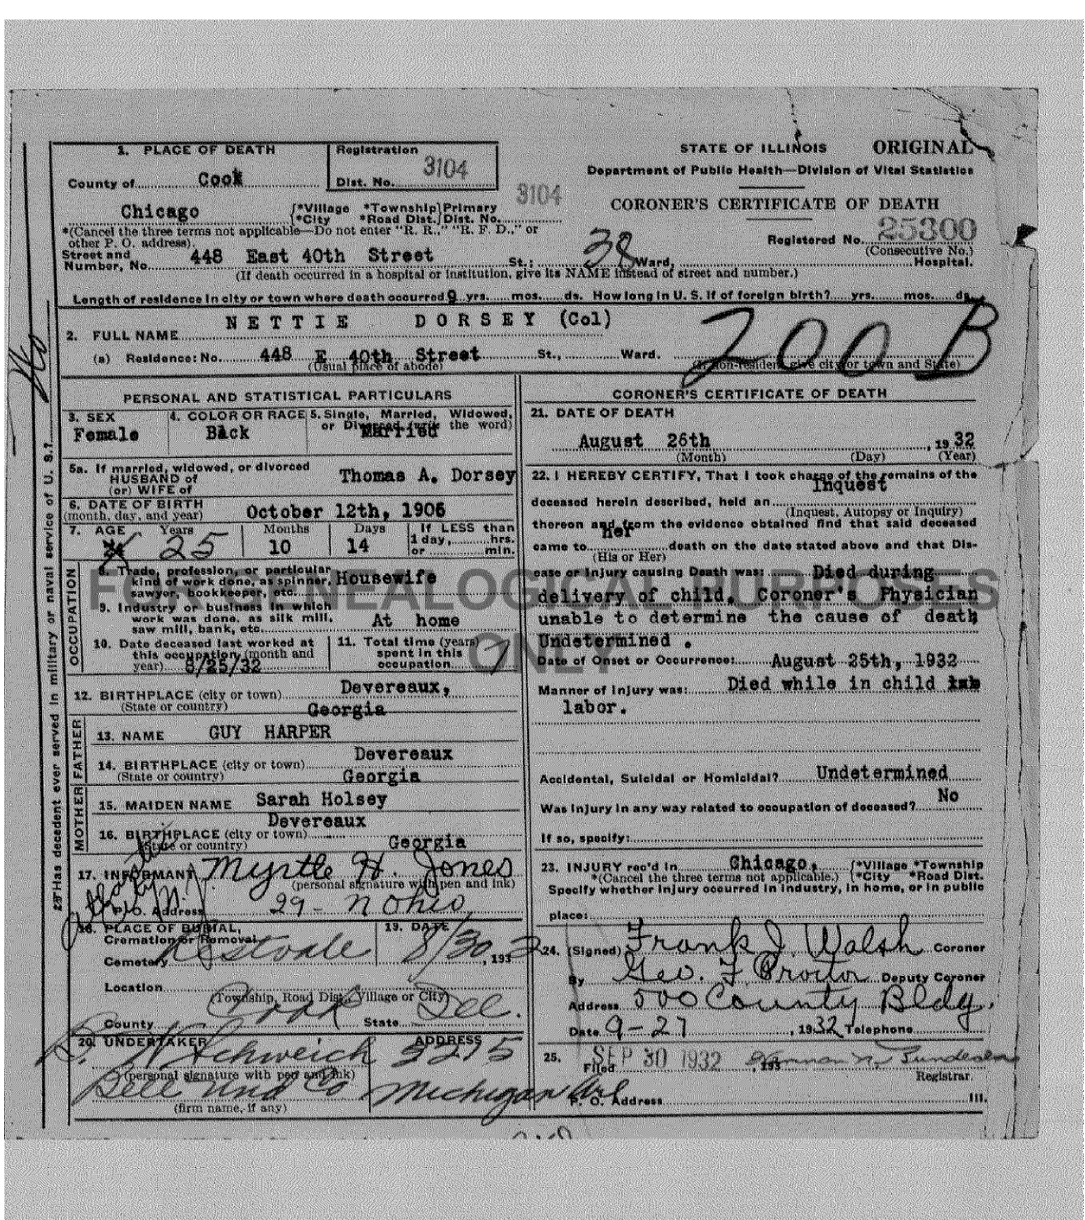
Figure 1. Certificate of Death, No. 25300, “NETTIE DORSEY (Col)” (30 September 1932).